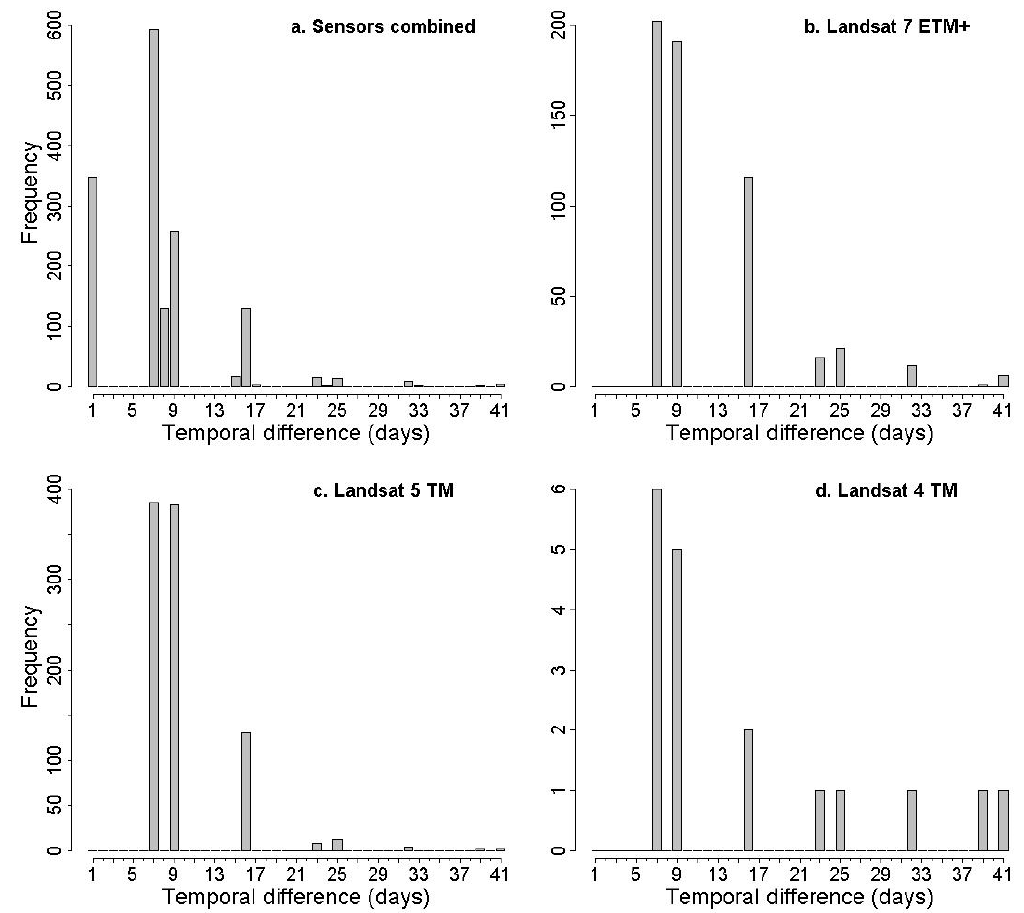
Figure 8. Histogram of the temporal differences between consecutive non-fill non-cloudy Landsat observations over the 36 year study period at the most observed non-fill non-cloudy CONUS ARD pixel location (located at 32°47'34.09"N 114°55'47.60"W, southern California, ARD tile h05v13) for ( a ) Landsat 4 TM, 5 TM and 7 ETM+ combined, ( b ) Landsat 7 ETM+, ( c ) Landsat 5 TM, ( d ) Landsat 4 TM.